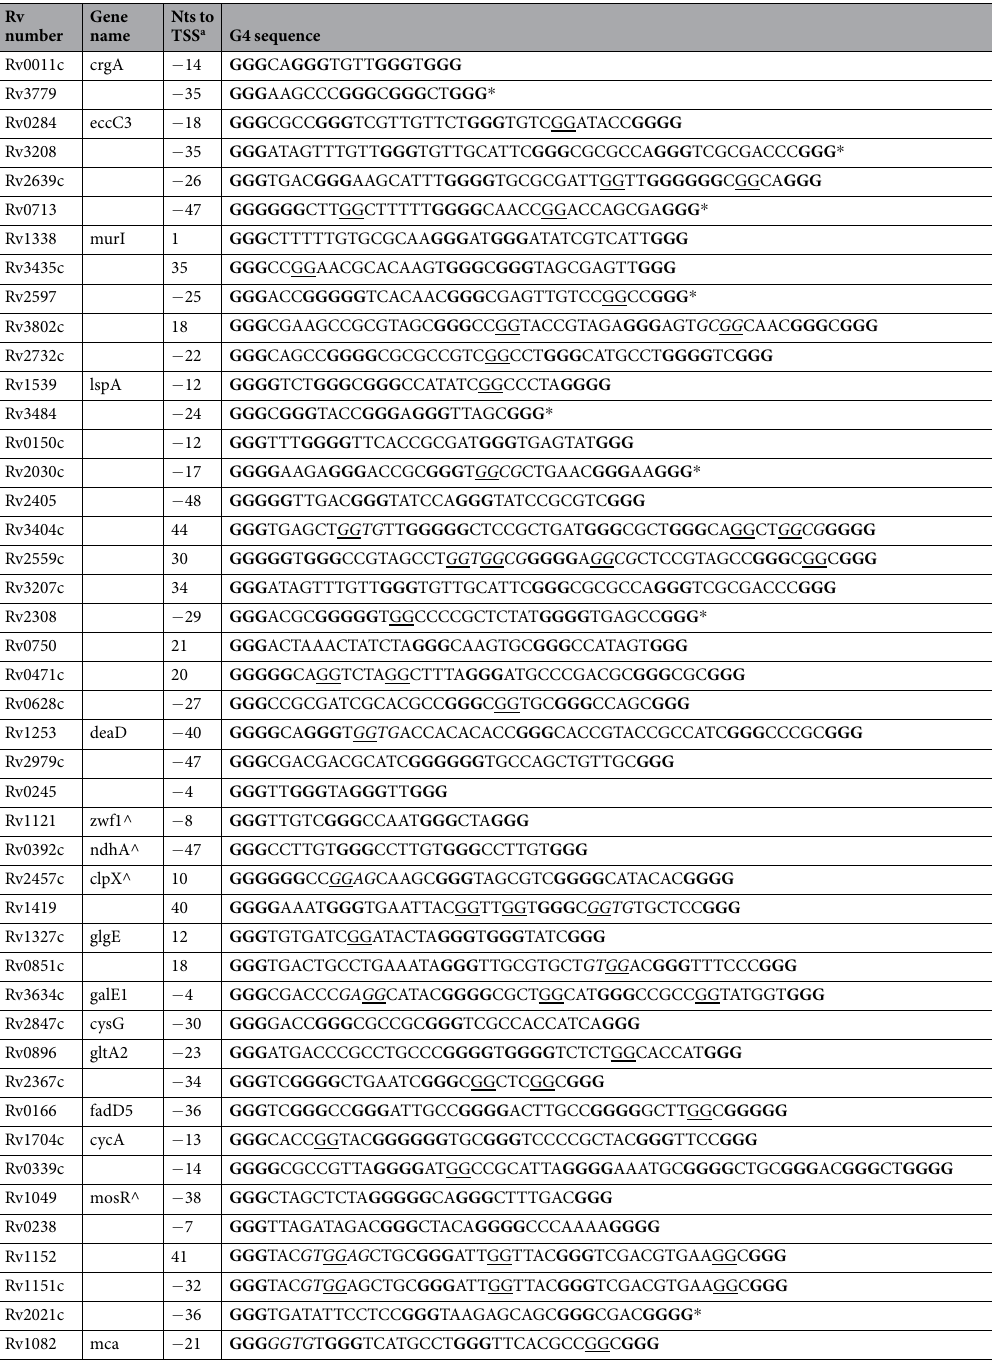
Table 2. G4 sequences upstream or overlapping TSS in the Mtb genome, forming G4s with at least three stacked tetrads (at least 3 Gs in each G-rich island) and with short or long score ≥ 2. G tracts with at least three Gs are shown in bold. GG tracts are underlined since they may aid G4 folding. Tracts with the potential to form a bulged G4 ( i.e . GXGG, where X is any of the three remaining bases) are additionally shown in italics. The symbol^ indicates genes, the corresponding G4 sequences of which were chosen for further investigation. Rv number is the gene numeration in the considered reference strain H37Rv. a Position of the last nt of the G4 motif with respect to the TSS. Asterisks indicate that the reported G4 sequence is in the reverse